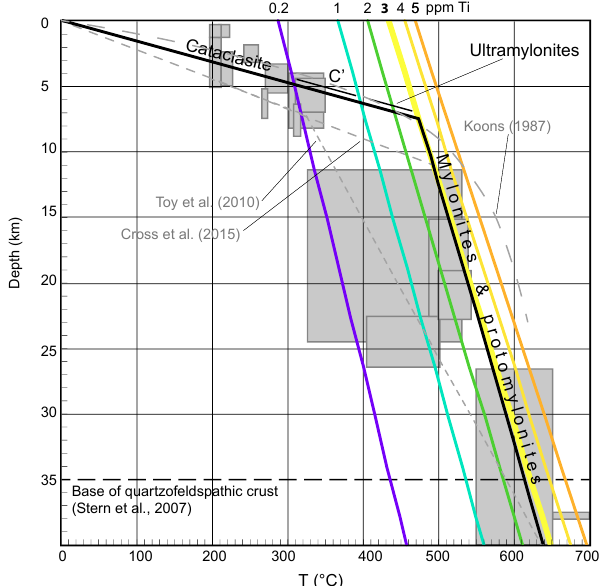
Figure 11. Temperature–depth diagram showing constraints on the Alpine Fault geothermal gradient from previous studies (grey boxes), proposed and previously proposed geothermal gradients (solid black and dashed lines, respectively), and experimentally determined constant-Ti contours (colored isopleths) covering the range of observed Ti-in-quartz concentrations. A Ti activity of 0.1 (Thomas et al., 2010) and crustal density of 2.7gcm − 3 are used to plot the isopleths. Ti activity is constrained by the fact that activi- ties larger than 0.1 would shift the isopleths to the left and require quartz recrystallization at unrealistically low quartz recrystalliza- tion temperatures ( < 300 ◦ C). Previous temperature–pressure con- straints are from Craw (1997), Holm et al. (1989), Green (1992), Grapes (1995), Cooper (1980), and Vry et al. (2004) as summarized by Toy et al.